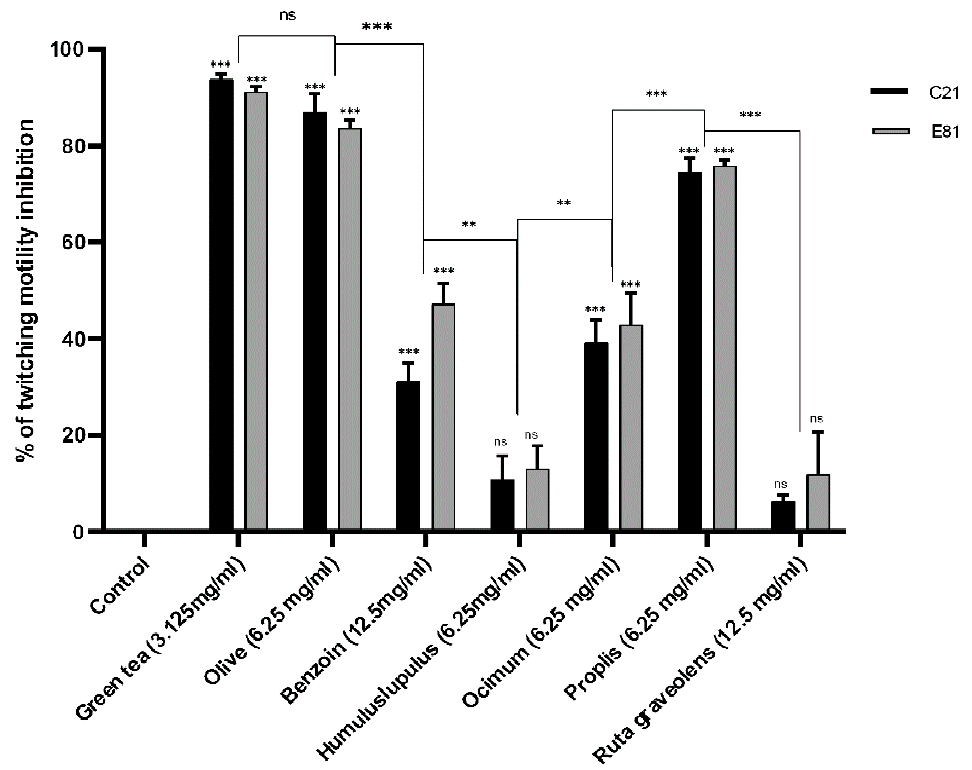
Figure 2. E ff ect of di ff erent herbal extracts on twitching motility of P. aeruginosa . Bar chart showing the percent inhibition of C21 and E81 twitching motility in the absence and presence of herbal extracts Camellia sinensis (3.125 mg / mL), Olea europaea (6.25 mg / mL), Styrax benzoin (12.5 mg / mL), Humulus lupulus (6.25 mg / mL), Ocimum basilicum (6.25 mg / mL), Propolis (6.25 mg / mL), and Ruta graveolens (12.5 mg / mL). Data are an average of three independent experiments. The results are presented by the mean ± SD. ns = nonsignificant; ** = p < 0.01; *** = p < 0.001: significance was compared to the respective control.